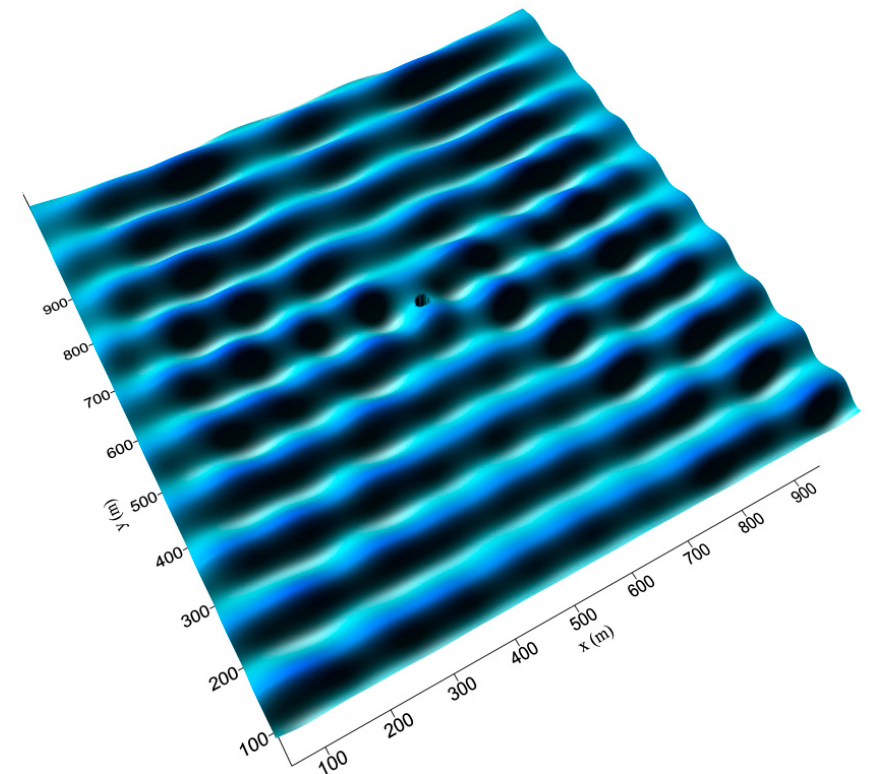
Figure 6. Perspective view of the free-surface elevation around a cylinder of a = 5.0 m and b / a = 1.0 situated at d = 10 m under the action of unit-amplitude regular waves of T = 8.0 s.